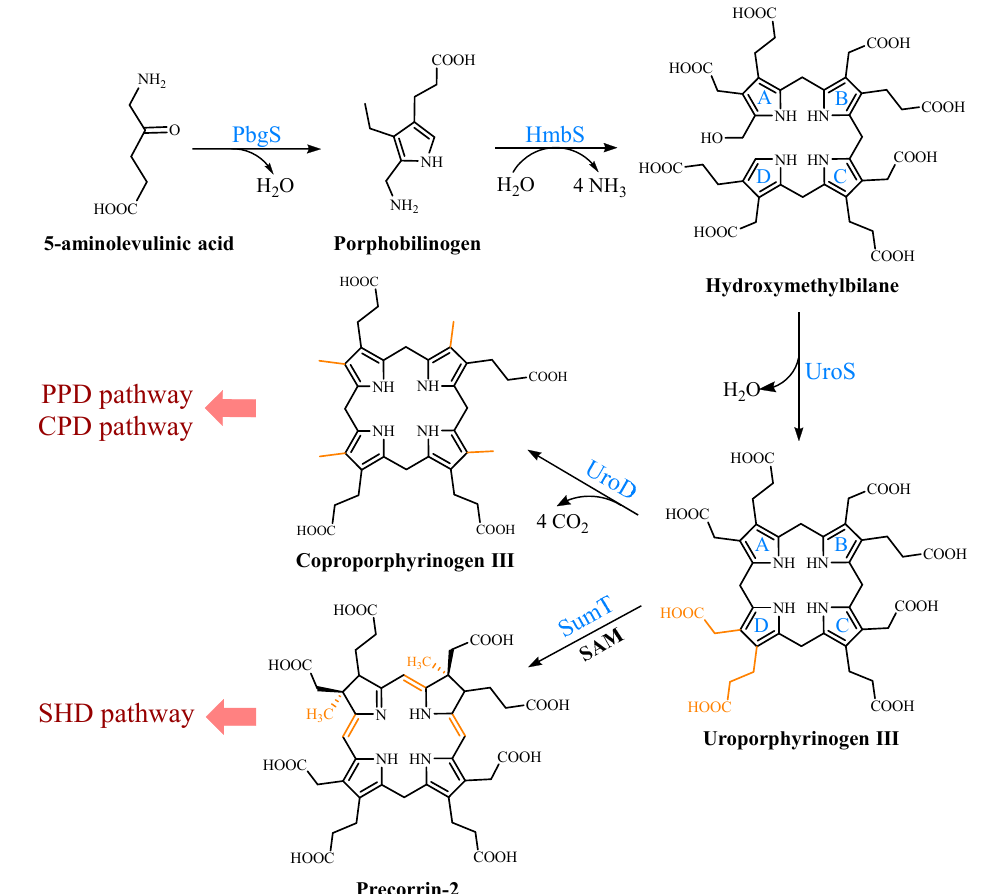
Figure 2. Formation of uroporphyrinogen III (UPG III) and the branching of the heme b biosynthesis. In nature, the pathway from 5-aminolevulinic acid (5-ALA) to UPG III is a highly conserved three-enzyme cascade. UPG III is decarboxylated by uroporphyrinogen III decarboxylase to form coproporphyrinogen III (CPG III), a reaction shared by the protoporphyrin-dependent (PPD) and coproporphyrin-dependent (CPD) pathways. In the siroheme-dependent (SHD) pathway, the C2 and C7 positions of UPG III are methylated by the SAM-dependent uroporphyrinogen III methyltransferase (SumT) to generate precorrin-2.